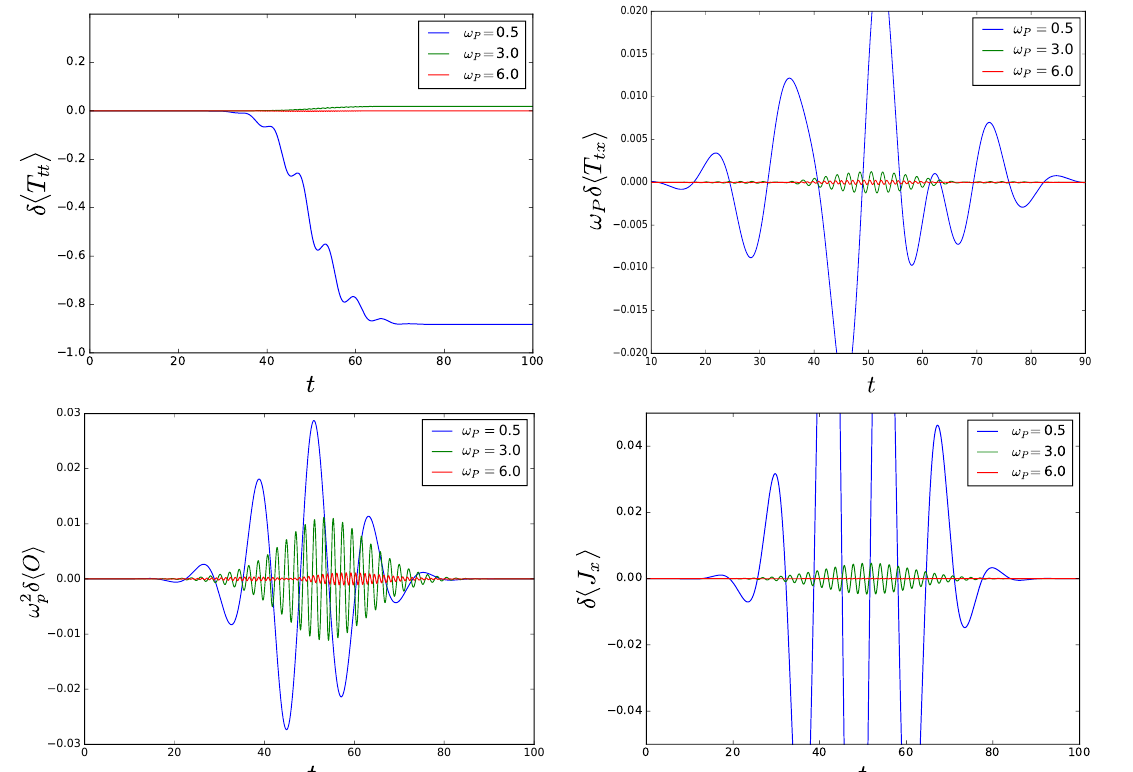
Figure 8 . Di(cid:11)erence between the expectation value obtained from numerics and from the large ! P analytic solution. The di(cid:11)erences are seen to decrease as ! P